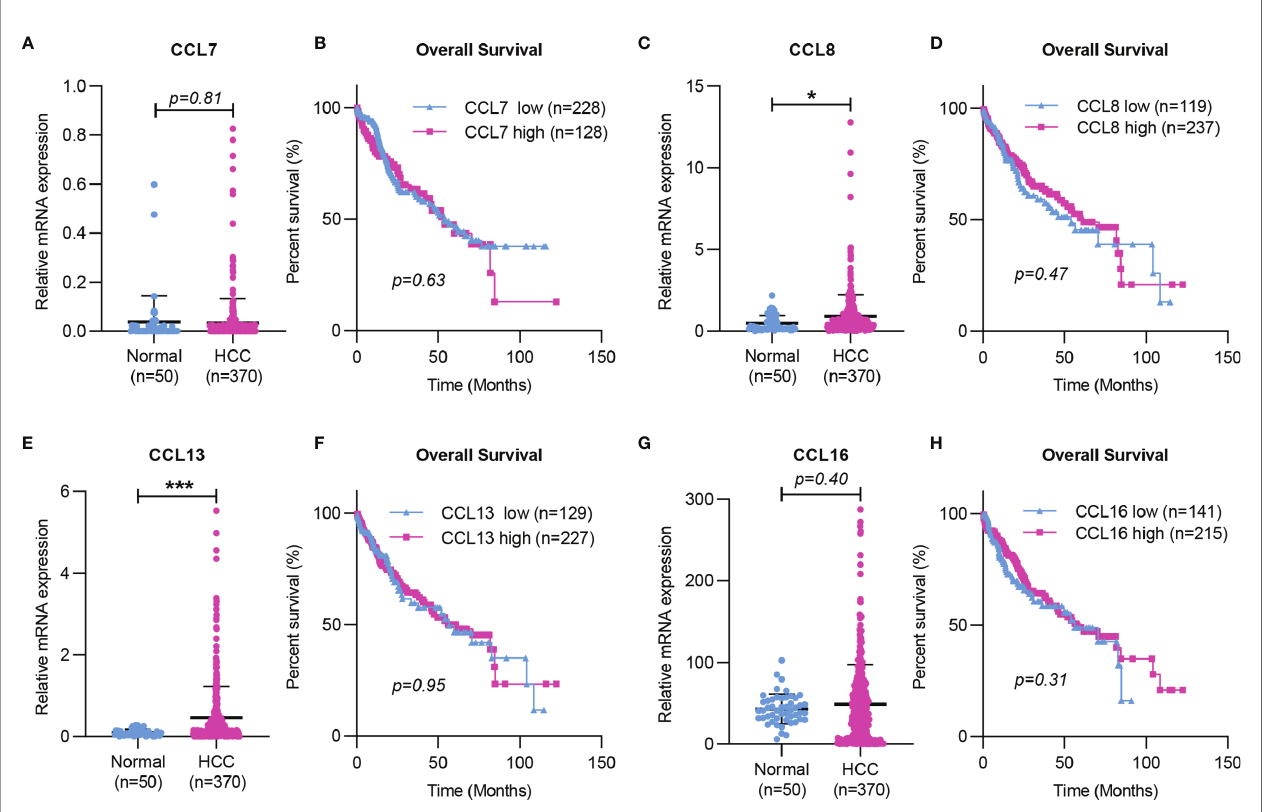
FIGURE 3 | Expression and Kaplan-Meier survival curves of CCL7, CCL8, CCL13, and CCL16 in HCC based on TCGA. (A, C, E, G) The mRNA expression of CCL7, CCL8, CCL13, and CCL16 in HCC tissues was determined by RNA-seq data from the TCGA LIHC dataset. (B, D, F, H) The correlation of CCL7, CCL8, CCL13, and CCL16 mRNA expression levels with overall survival time was determined by RNA-seq in the TCGA LIHC dataset. TCGA, The Cancer Genome Atlas. (*P < 0.05; ***P <